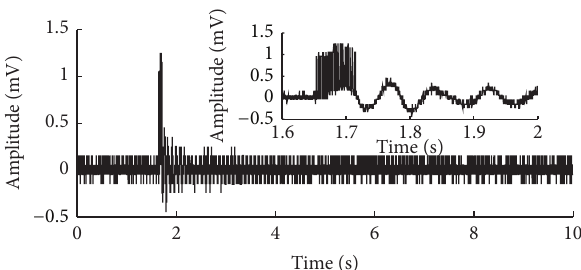
Figure 9: Original TEM signal obtained during coal blasting rupture.